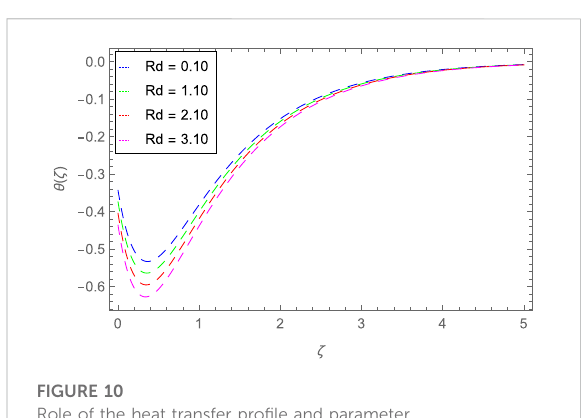
FIGURE 12 Role of the gyrotactic microorganism concentration pro fi le and